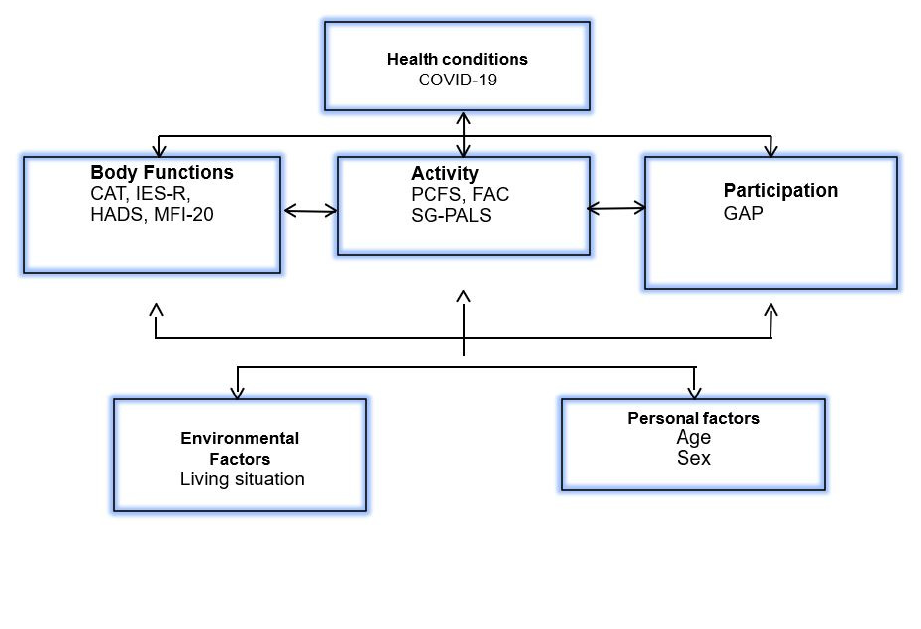
Figure 1. Patient evaluation according to the International Classification of functioning (ICF).